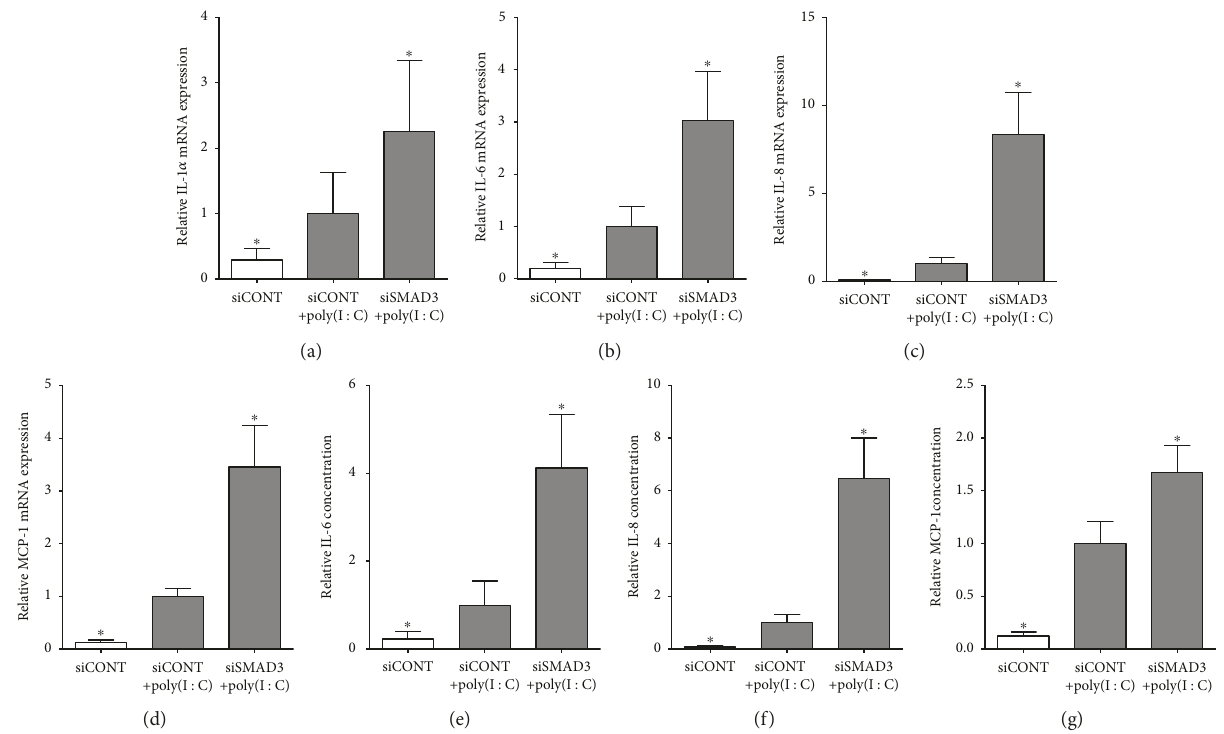
Figure 4: E ff ect of siSMAD3 on poly(I:C)-induced proin fl ammatory cytokines and chemokines. Human primary myometrial cells, obtained from women at term in the absence of labour, were transfected with or without 50 nM siSMAD3 or 50nM siCONT for 48h and then treated with 5 μ g/ml poly(I:C) for an additional 24h ( n = 5 patients). (a – d) Expression of IL-1 α , IL-6, IL-8, and MCP-1 mRNA was analysed by qRT- PCR. (e – g) IL-6, IL-8, and MCP-1 concentrations in the incubation medium were assayed by ELISA. For all data, the fold change was calculated relative to poly(I :C)-stimulated siCONT-transfected cells and displayed as mean ± SEM. ∗ P ≤ 0 05 vs. poly(I:C)-stimulated siCONT-transfected cells (one-way